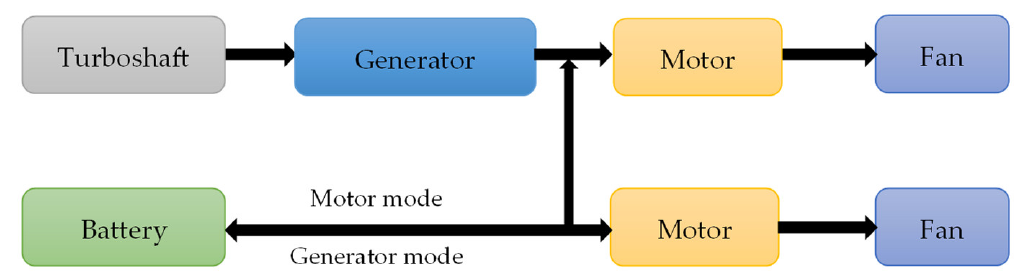
Figure 5. Serial hybrid [32].